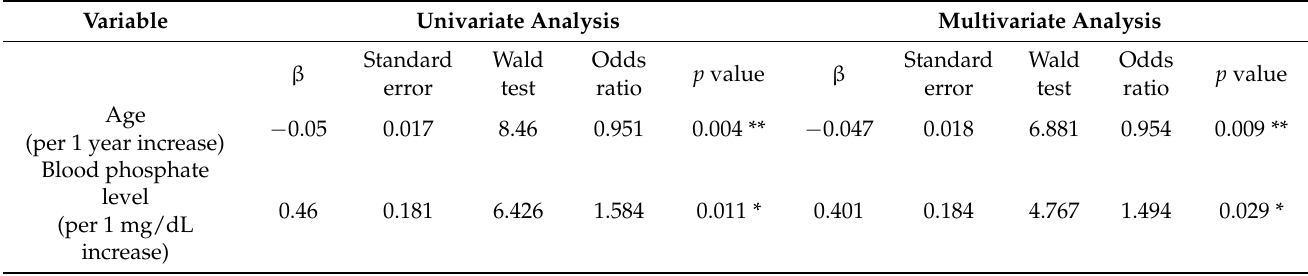
Table 7. Predictors for torus mandibularis in hemodialysis patients (n = 322). Variable Univariate Analysis Multivariate